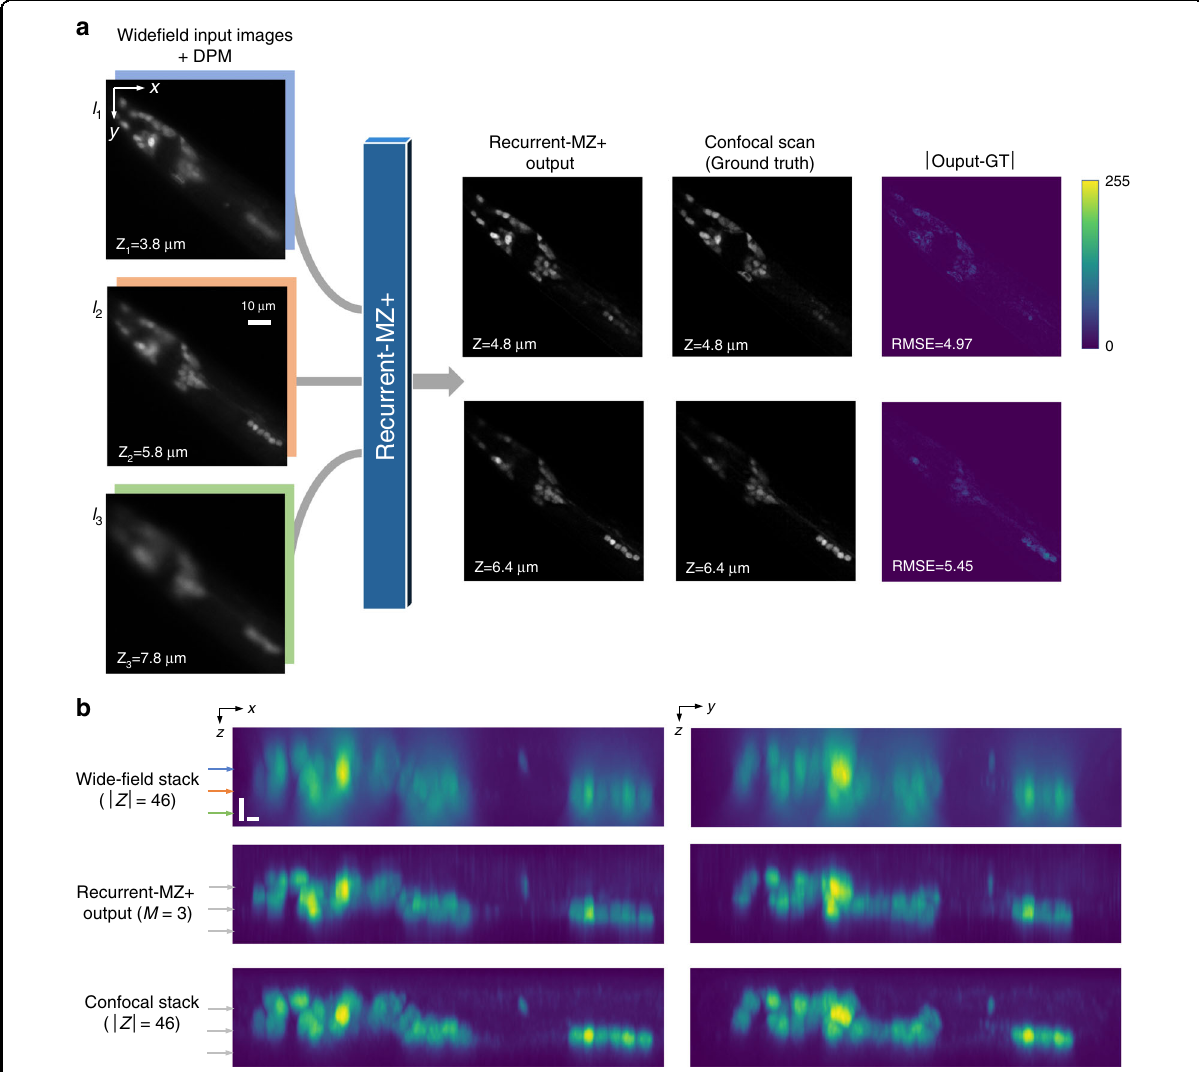
Fig. 8 Wide- fi eld to confocal: cross-modality volumetric imaging using Recurrent-MZ + . a Recurrent-MZ + takes in M = 3 wide- fi eld input images along with the corresponding DPMs, and rapidly outputs an image at the designated/desired axial plane, matching the corresponding confocal scan of the same sample plane. b Maximum intensity projection (MIP) side views ( x – z and y – z ) of the wide- fi eld (46 image scans), Recurrent-MZ + ( M = 3) and the confocal ground truth image stack. Each scale bar is 2 μ m. Horizontal arrows in ( b ) mark the axial planes of I 1 , I 2 and I 3 . Also see Video